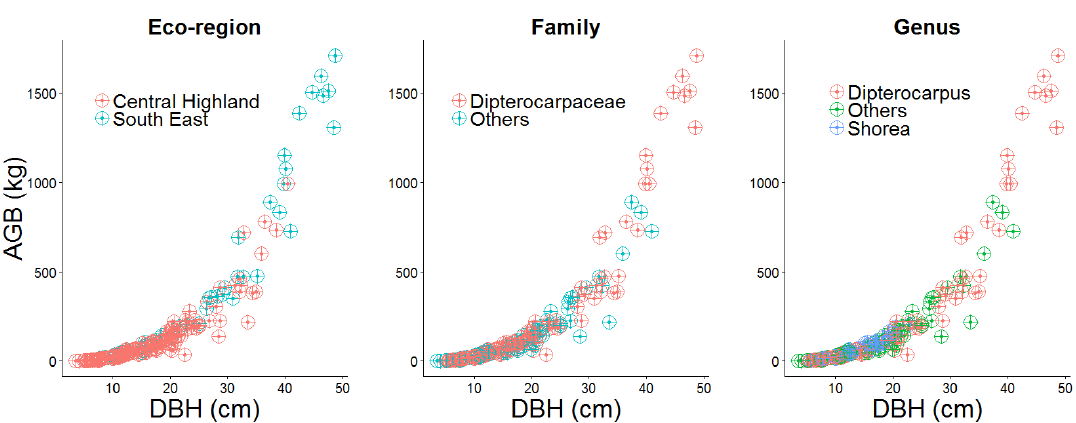
trend of relationship between AGB and DBH follows power model.